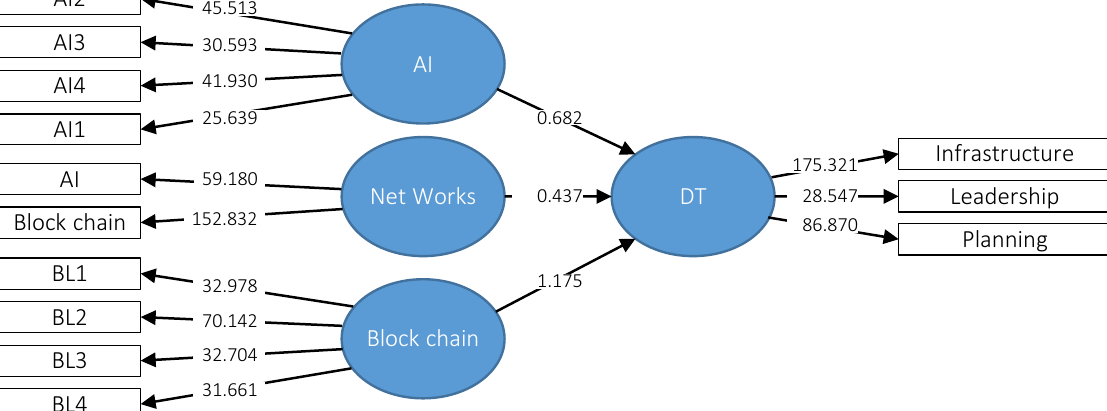
Figure 2. Employing network strategic capabilities on digital